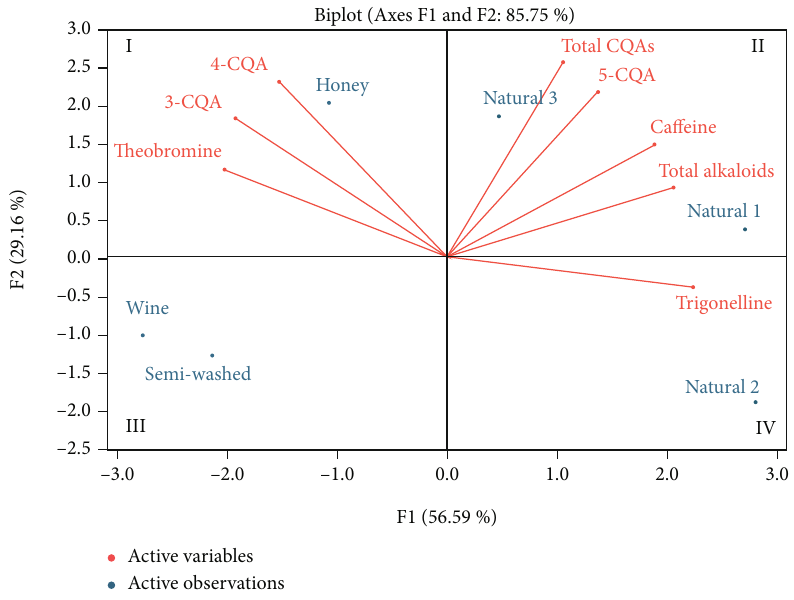
Figure 3: Biplot of ca ff eoylquinic acid (CQA) and alkaloid composition of green bean extract of Excelsa co ff ee obtained from di ff erent processes. Natural 1, 2, and 3 samples were from di ff erent farmers. Natural 1, wine, honey, and semiwashed samples were from same farmer. The value displayed in the fi gure is the average of three replications. Table 1: Volatile compound classes of green and roasted Excelsa co ff ee powder from di ff erent plantation condition and di ff erent postharvest